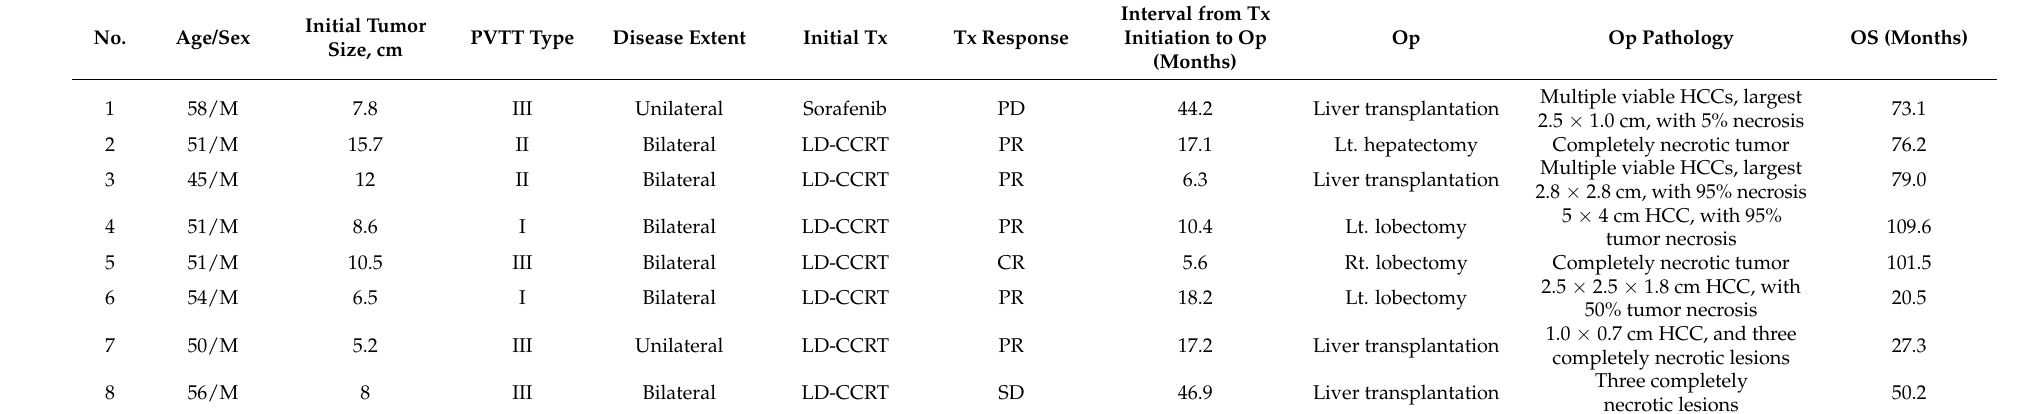
Table 3. Patient and tumor characteristics in those who underwent surgical